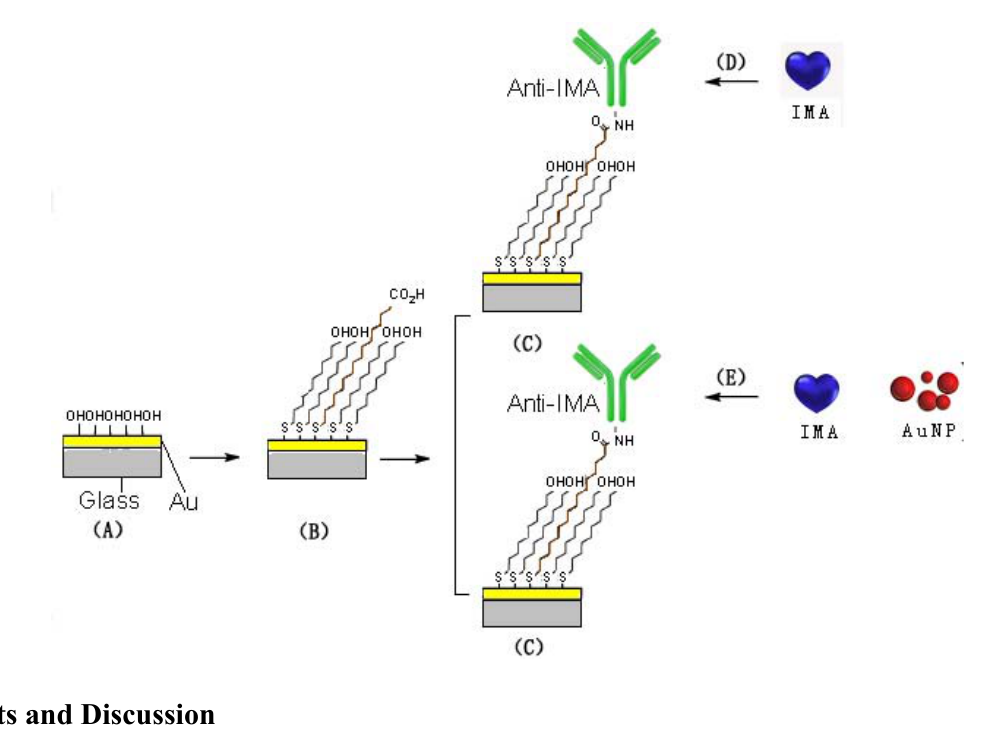
Figure 1. Sequential assay format: ( A ) a clean chip ( B ) a mSAM gold surface, ( C ) an Anti-IMA immobilized sensor surface, ( D ) IMA binding on the sensor surface(Format A), ( E ) IMA/AuNP binding on the sensor surface(Format B): both (D and E) return to (C) after surface